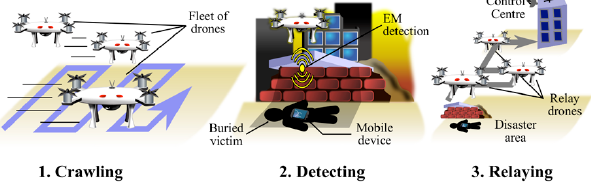
Figure 8. Automated victim localisation